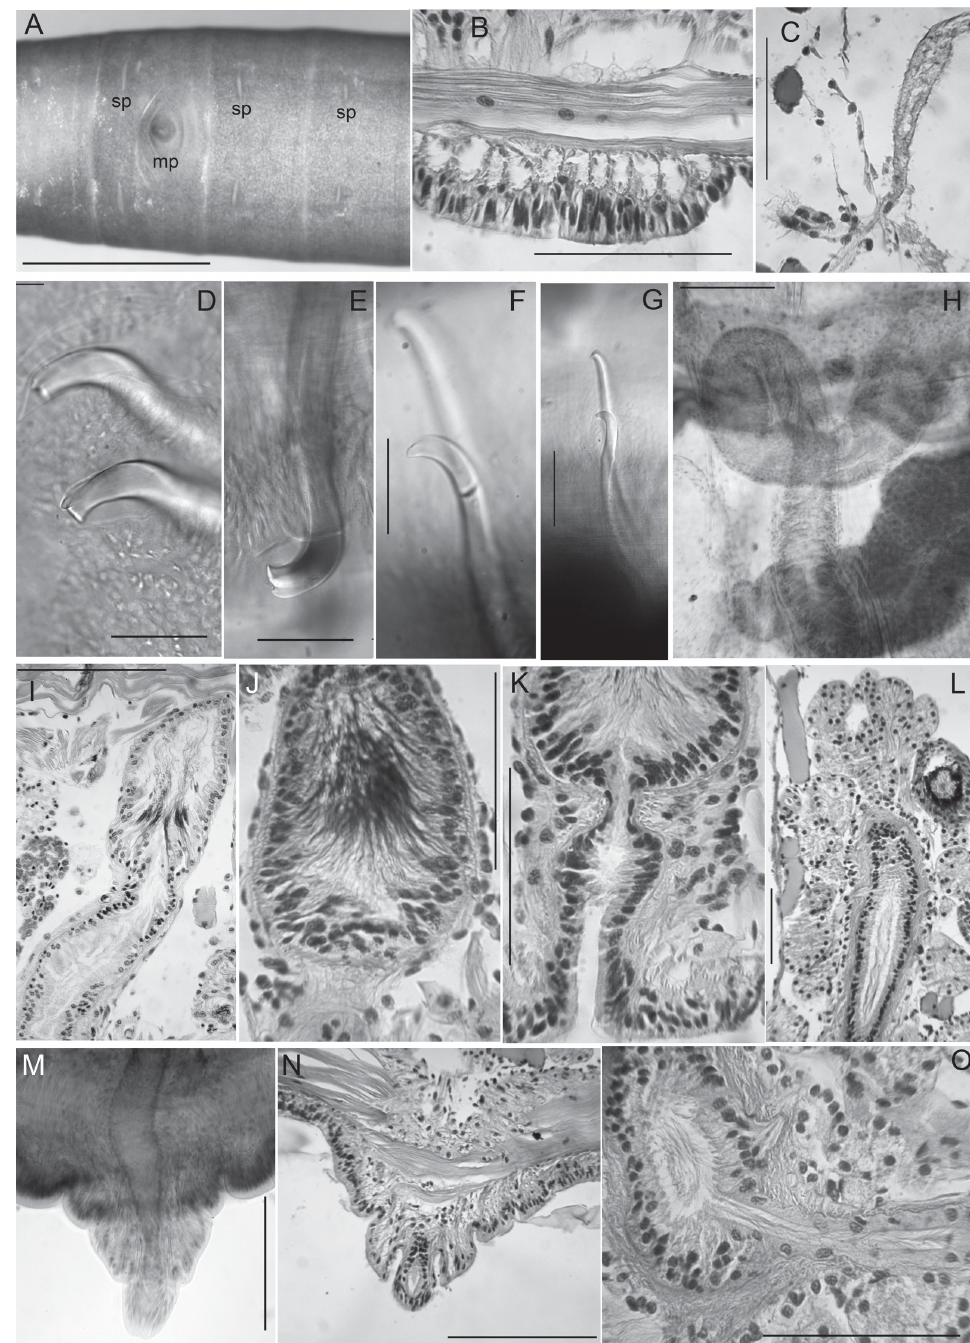
Fig. 5. Kincaidiana smithi Fend & Rodriguez sp. nov., from the type locality. B–C, I–L, N–O from sagittal sections; D–H, M from dissections. A . Ventral view of an entire worm, stained with hematoxylin, showing positions of genital pores. B . Body wall in segment III, showing longitudinal and transverse muscle layers. C . Nephridial funnel and postseptal expansion. D . Chaetae in V dorsal. E . IV ventral. F–G . Chaetae in posterior segments; (F) is detail of tip, showing slight keel. H . Spermatheca. I . Junction of spermathecal “duct” and “ampulla”; sperm are in the ampullar part. J . Ectal end of spermathecal duct, with sperm lined up along epithelium. K . Spermathecal vestibule and ectal end of duct, with muscular sphincter. L . Atrium with prostate glands. M–N . Penis and male porophore. O . Vas deferens joining atrium near middle. Scale bars: A = 1 mm; B–C, G, J–L, O = 100 µm; D–F = 50 µm; H–I, M–N = 200